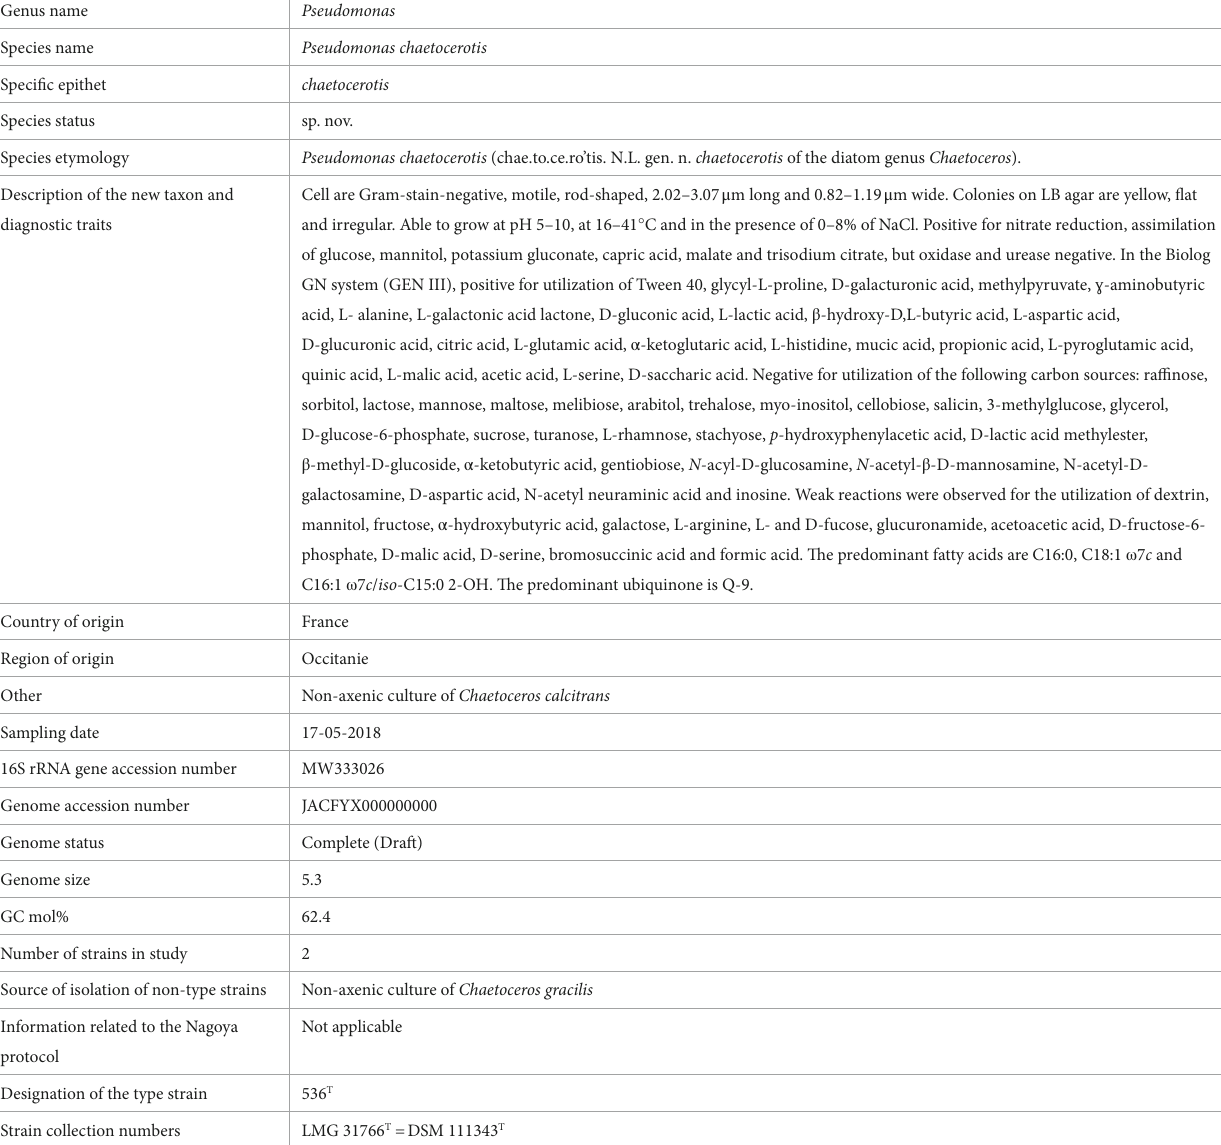
TABLE 2 Protologue of Pseudomonas chaetocerotis 536 T